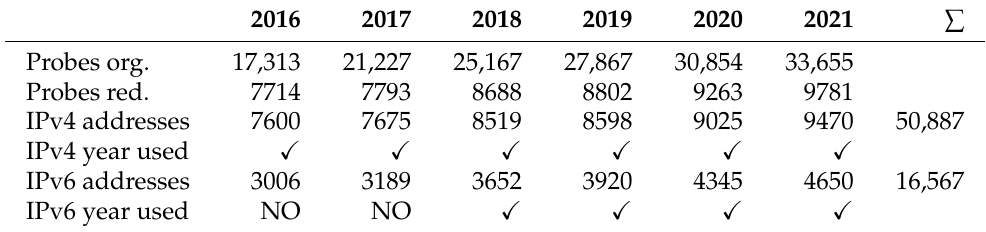
Table 1. Historical ground truth data over years.